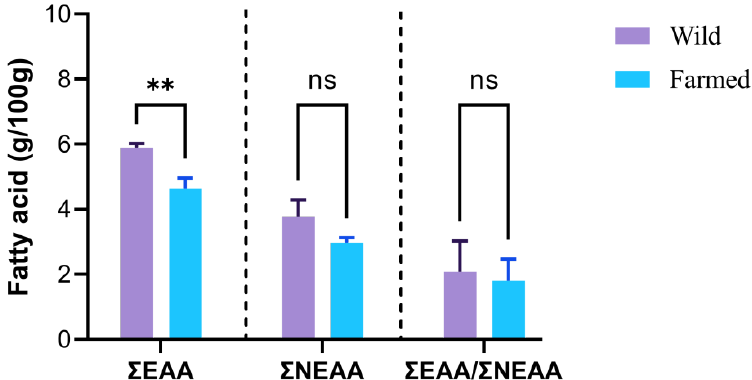
Table 3. Comparison of wild and farmed pangasius catfish amino acid contents mg/g to the amino acid requirements of infants and children of different age groups, based on FAO (2013) standard.